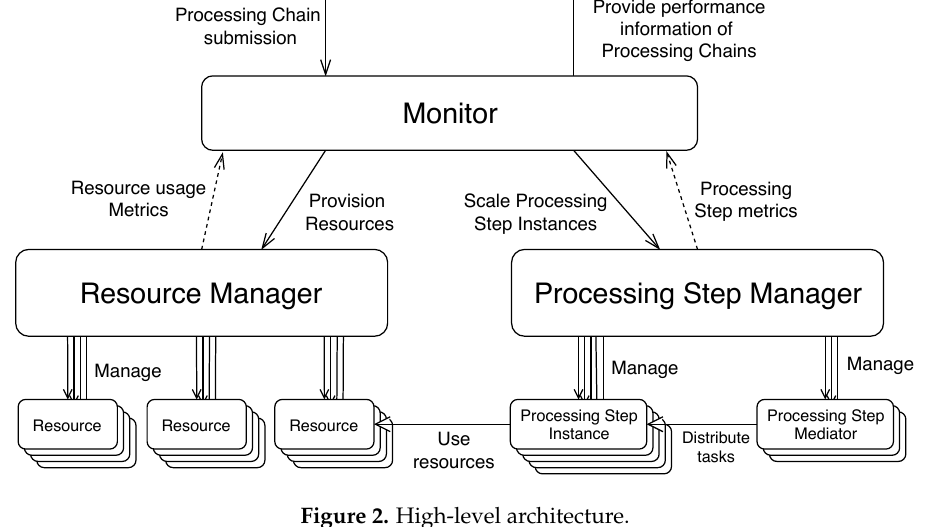
Figure 2. High-level architecture.